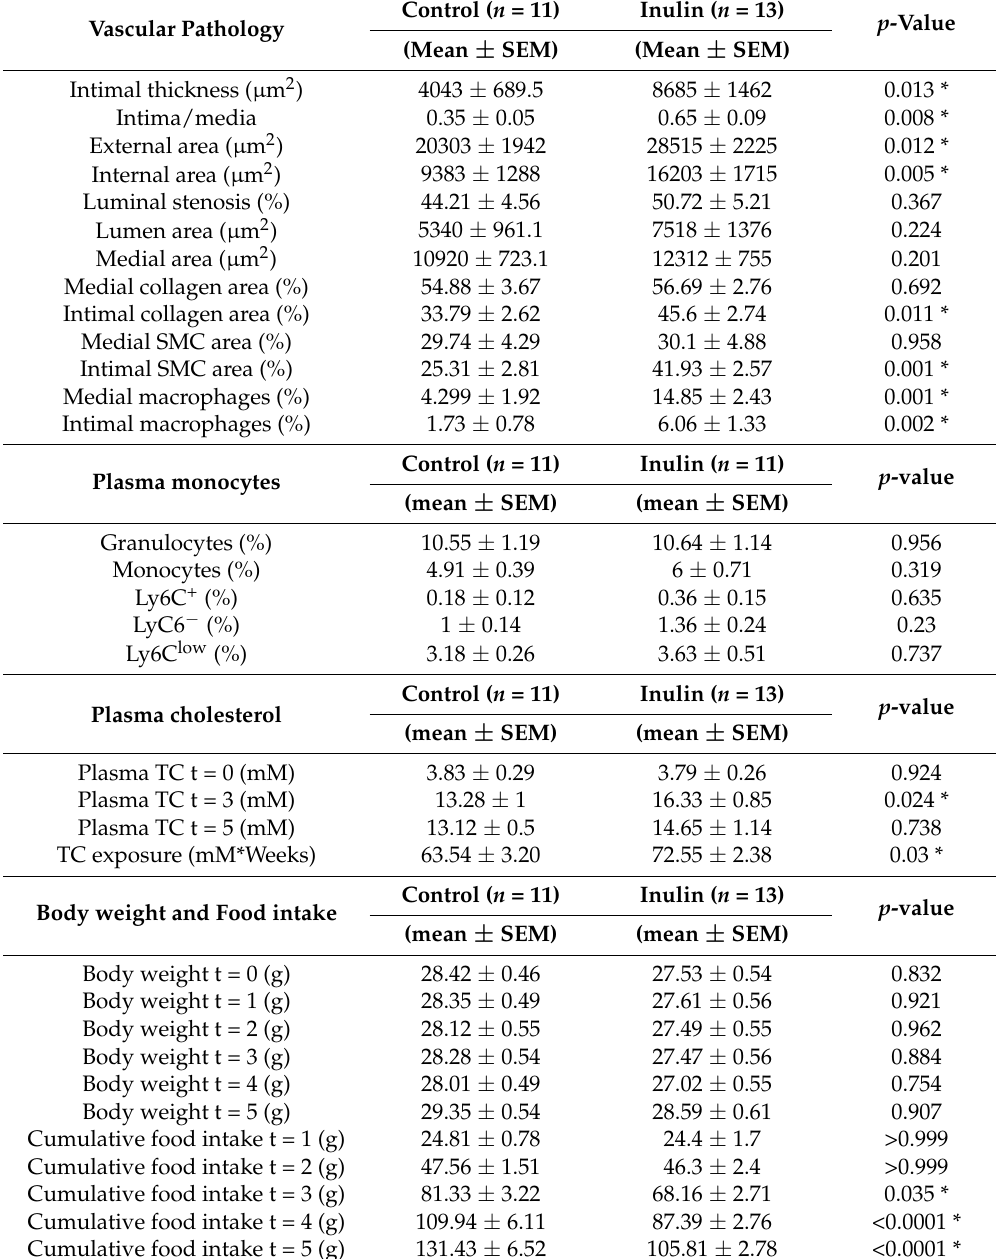
Table 2. Experimental measurements including vascular pathology, plasma monocytes, plasma cholesterol, body weight, and food